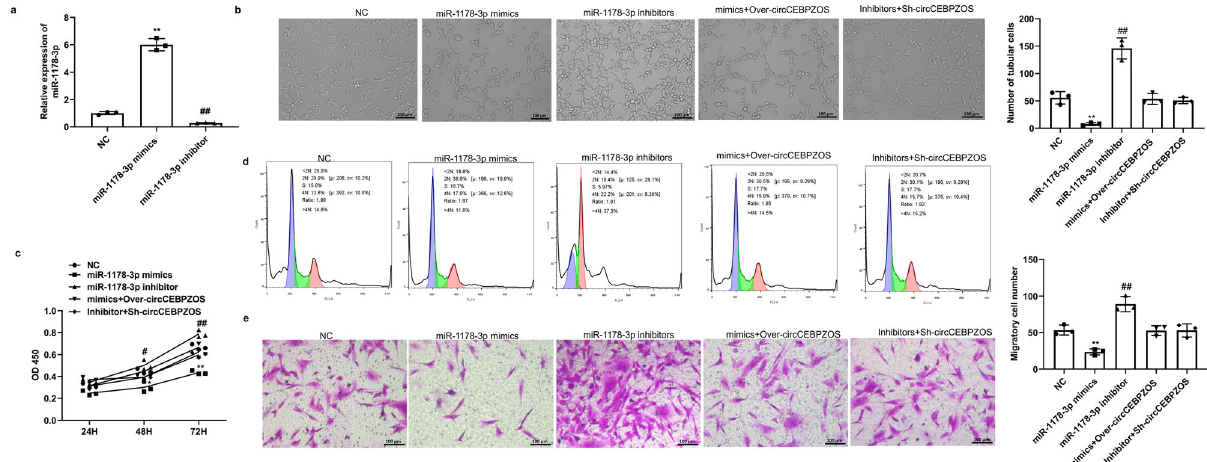
Fig. 5 miR-1178-3p inhibited angiogenesis of CMECs and proliferation and migration of VSMCs. a Expression of miR-1178-3p was detected using qRT – PCR in CMECs treated with miR-1178-3p mimics or inhibitors; b Tube formation analysis to detect capillary-like structures in the miR-1178-3p mimic group or miR-1178-3p inhibitor group and rescued by circCEBPZOS, Bar = 200 μ m; c CCK-8 assay was used to detect the viability of VSMCs in the miR- 1178-3p mimics or miR-1178-3p inhibitor group and rescued by circCEBPZOS at 24 h, 48 h and 72 h; d Flow cytometry was used to detect the cell cycle of VSMCs in the miR-1178-3p mimics or miR-1178-3p inhibitor group and rescued by circCEBPZOS; e Migration of VSMCs was detected by Transwell assay when miR-1178-3p was overexpressed or suppressed and rescued by circCEBPZOS, Bar = 200 μ m. Data are mean ± SD. ** P < 0.01, miR-1178-3p